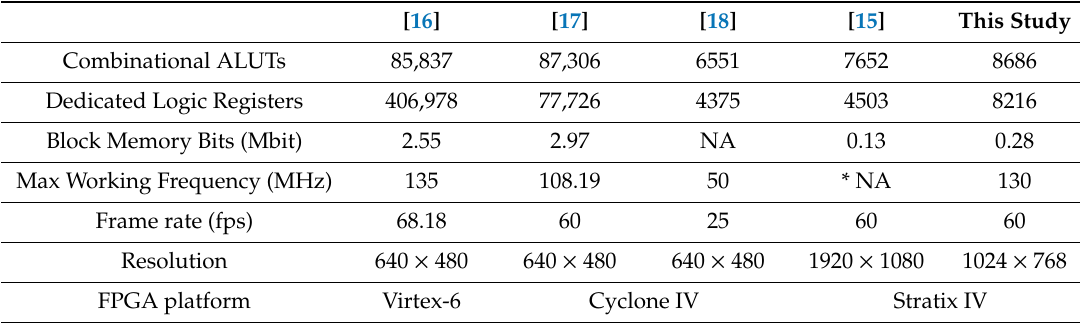
Table 2. Resource